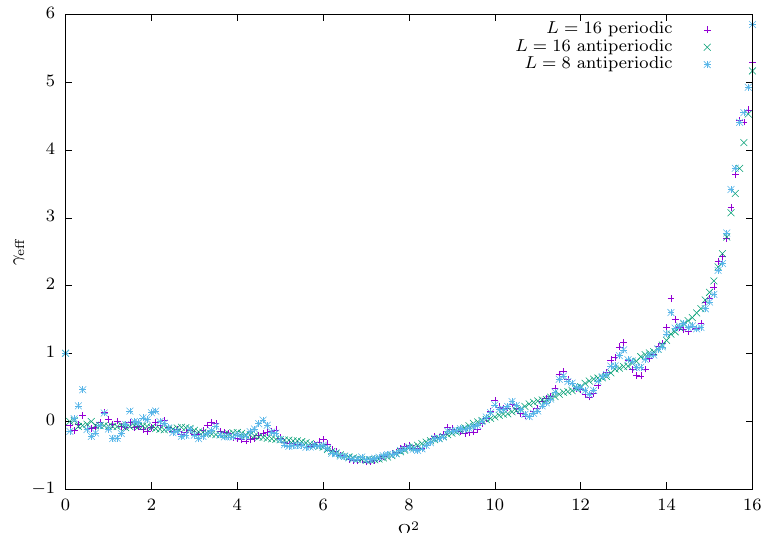
Figure 2. Effective anomalous dimension γ eff obtained from using eq. (3.3) to fit the analytic mode number of the free lattice D † D operator across the window [Ω 2 , Ω 2 + 1] . Two different A ∗ volumes 8 4 and 16 4 are compared, the latter considering both periodic and antiperiodic fermion BCs in the time direction.